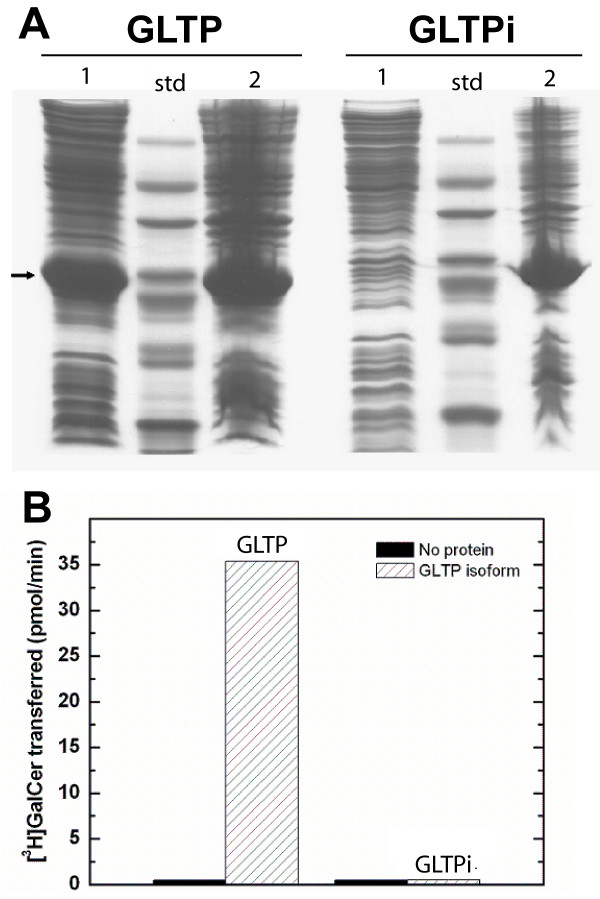
Heterologous Expression and Glycolipid Intermembrane Transfer Activity of Human GLTP Homologs. A. Heterologous expression of GLTP homologs in E. coli using pET-30 vector shown by SDS-PAGE. Arrow shows migration position of 6xHis-S-GLTP homologs (~25 kDa). GLTP = left panel; Intronless GLTP (GLTPi) = right panel; Lane 1 = soluble fraction; Lane 2 = Inclusion body pellet. Std = molecular weight standards. B. Intermembrane glycolipid transfer activity of GLTP homologs. [3H]GalCer transfer measured as described in Methods and Materials. The bars represent the averages of 6 assays performed using 1.0 μg of GLTP homolog.